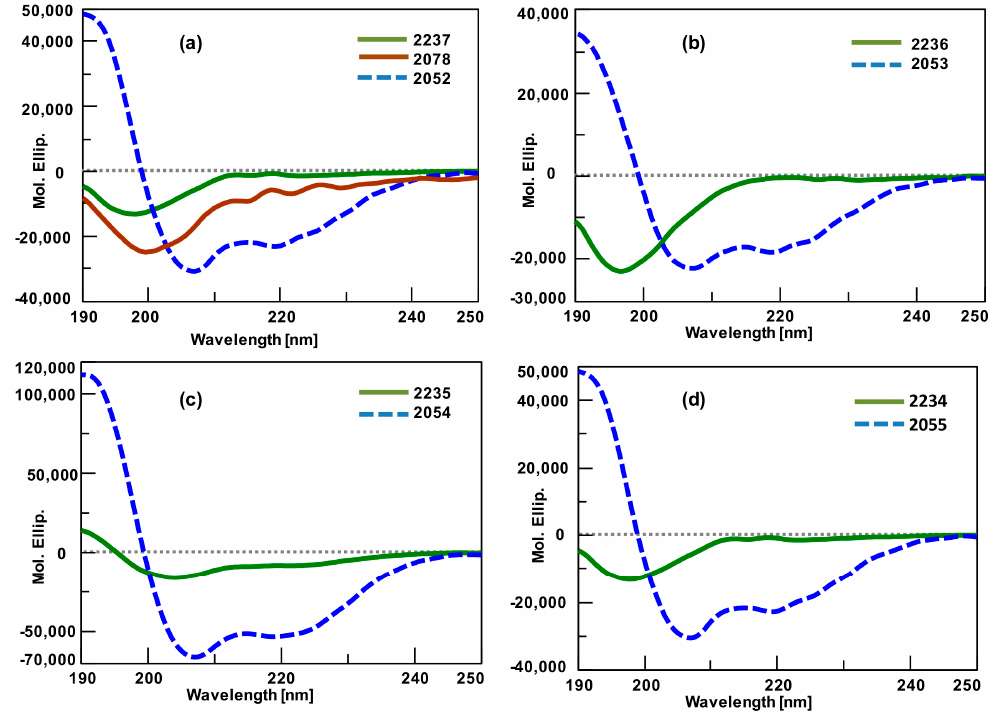
Figure 4. Circular dichroism of linear and conformationally restricted peptides: ( a ) Linear peptides 1 (2237 and 2078), and Helix 1 (2052); ( b ) Linear peptide 2 (2236) and Helix 2 (2053); ( c ) Linear peptide 3 (2235) and Helix 3 (2054); ( d ) Linear peptide 4 (2234) and Helix 4 (2055).